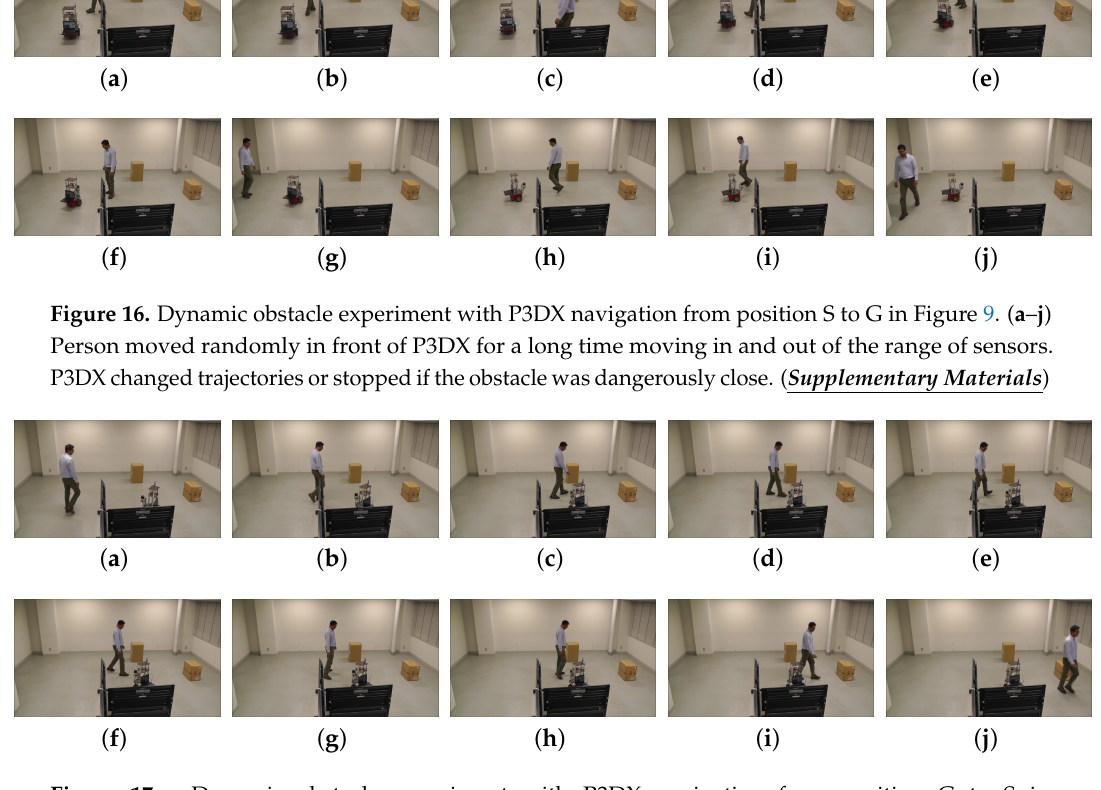
Figure 17. Dynamic obstacle experiment with P3DX navigation from position G to S in Figure 9. ( a – j ) To further test the method under pressure, a person moved randomly near P3DX. ( Supplementary Materials